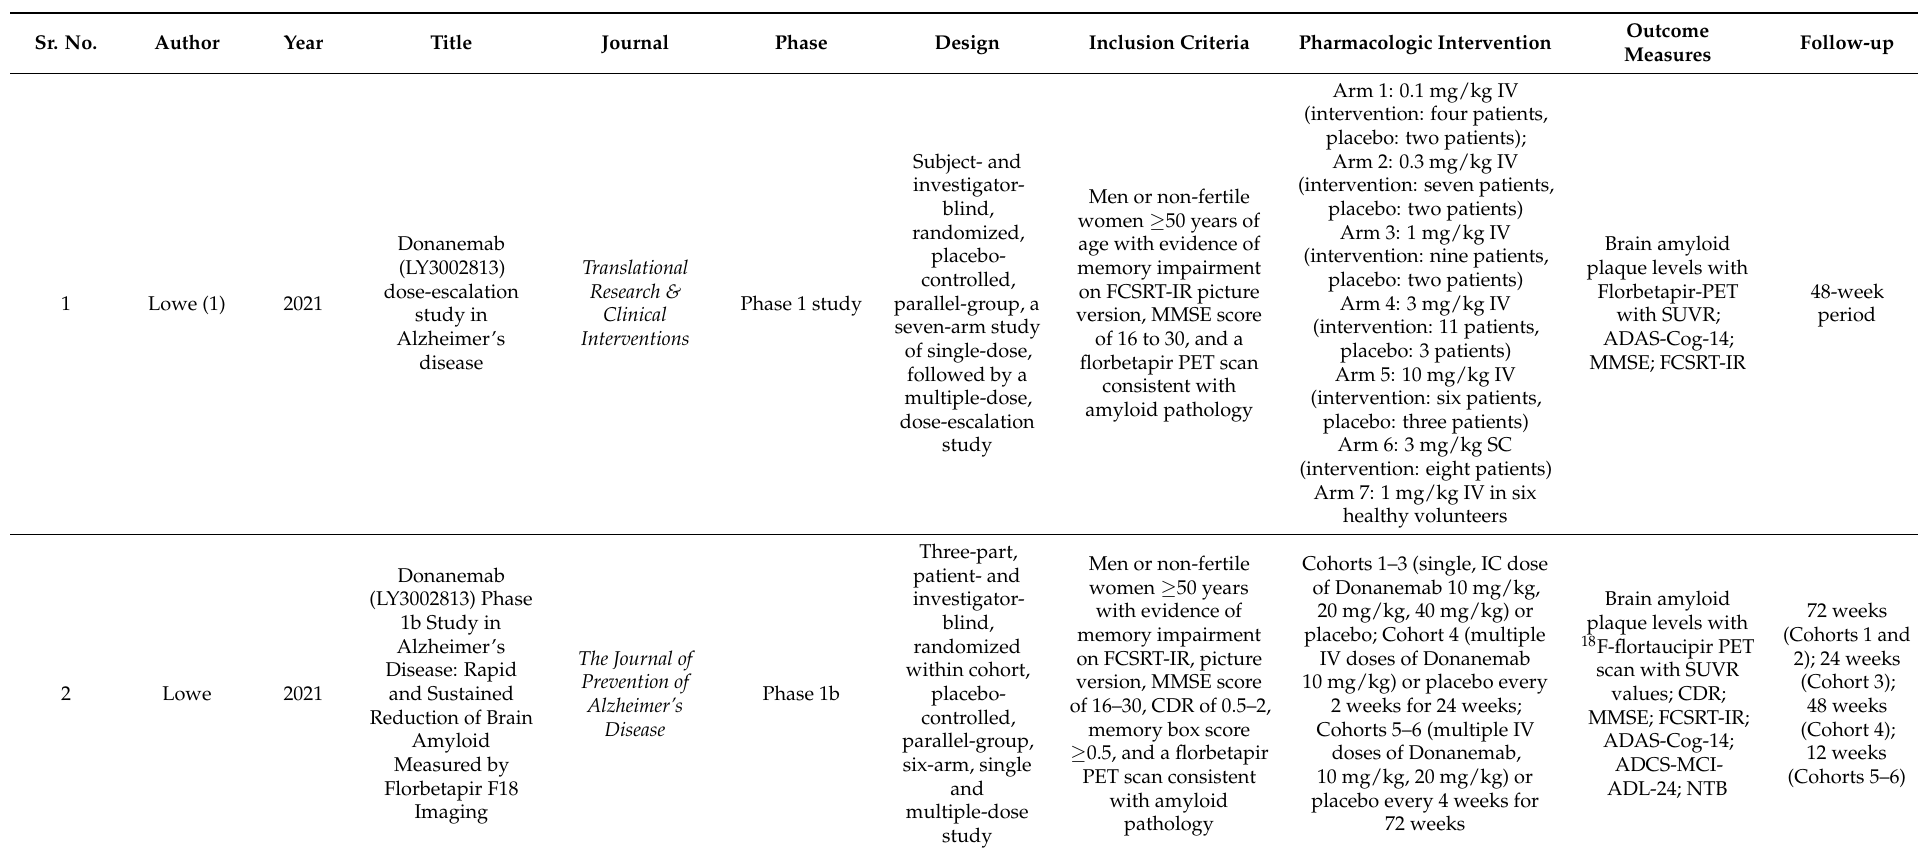
Table 1. Baseline characteristics and overview of the included